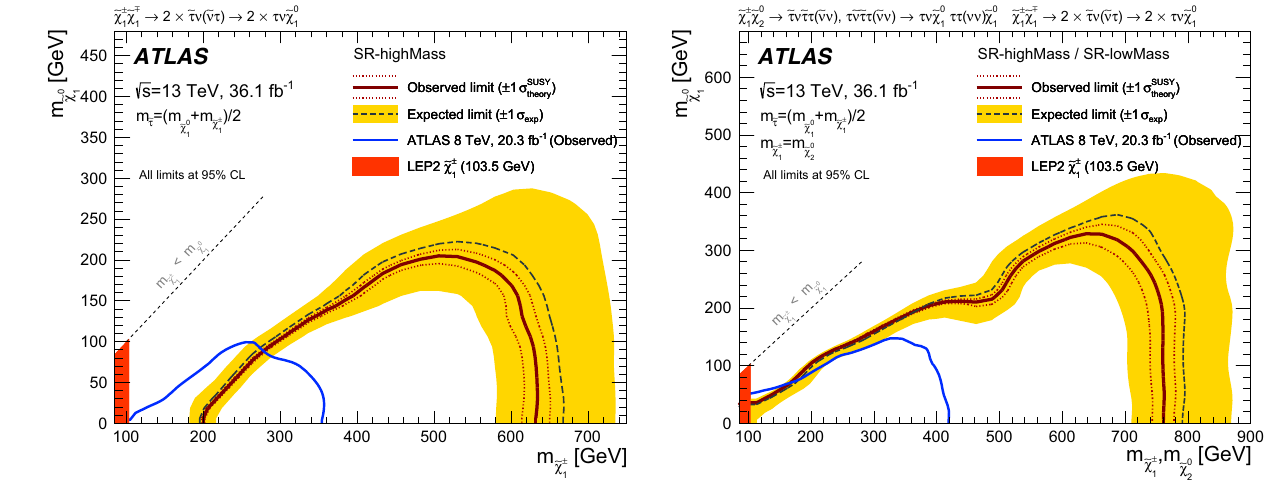
± ˜ χ 0 1 , 2 ) = 600 GeV and m ( ˜ χ 0 1 ) = 100 GeV) on the left, for